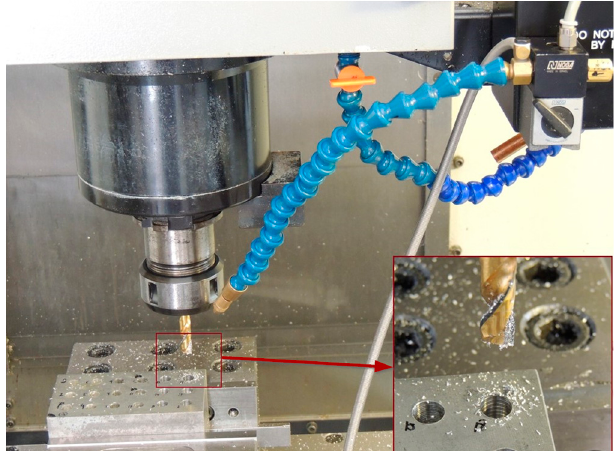
Figure 2. General view of the drilling process and minimum quantity lubrication (MQL) system and tool detail after machining.